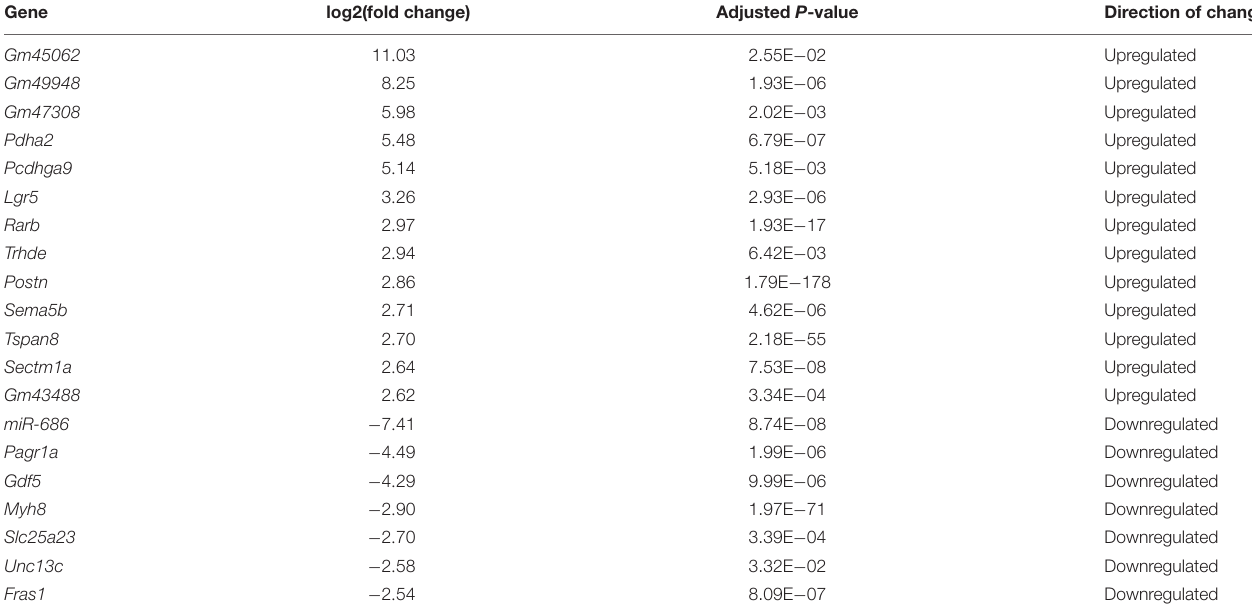
TABLE 1 | Top altered genes in RNA sequencing (RNA-seq). Gene log2(fold change) Adjusted P